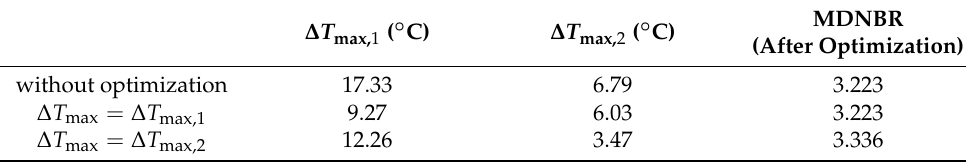
Table 6. Comparison of optimization effects of two temperature